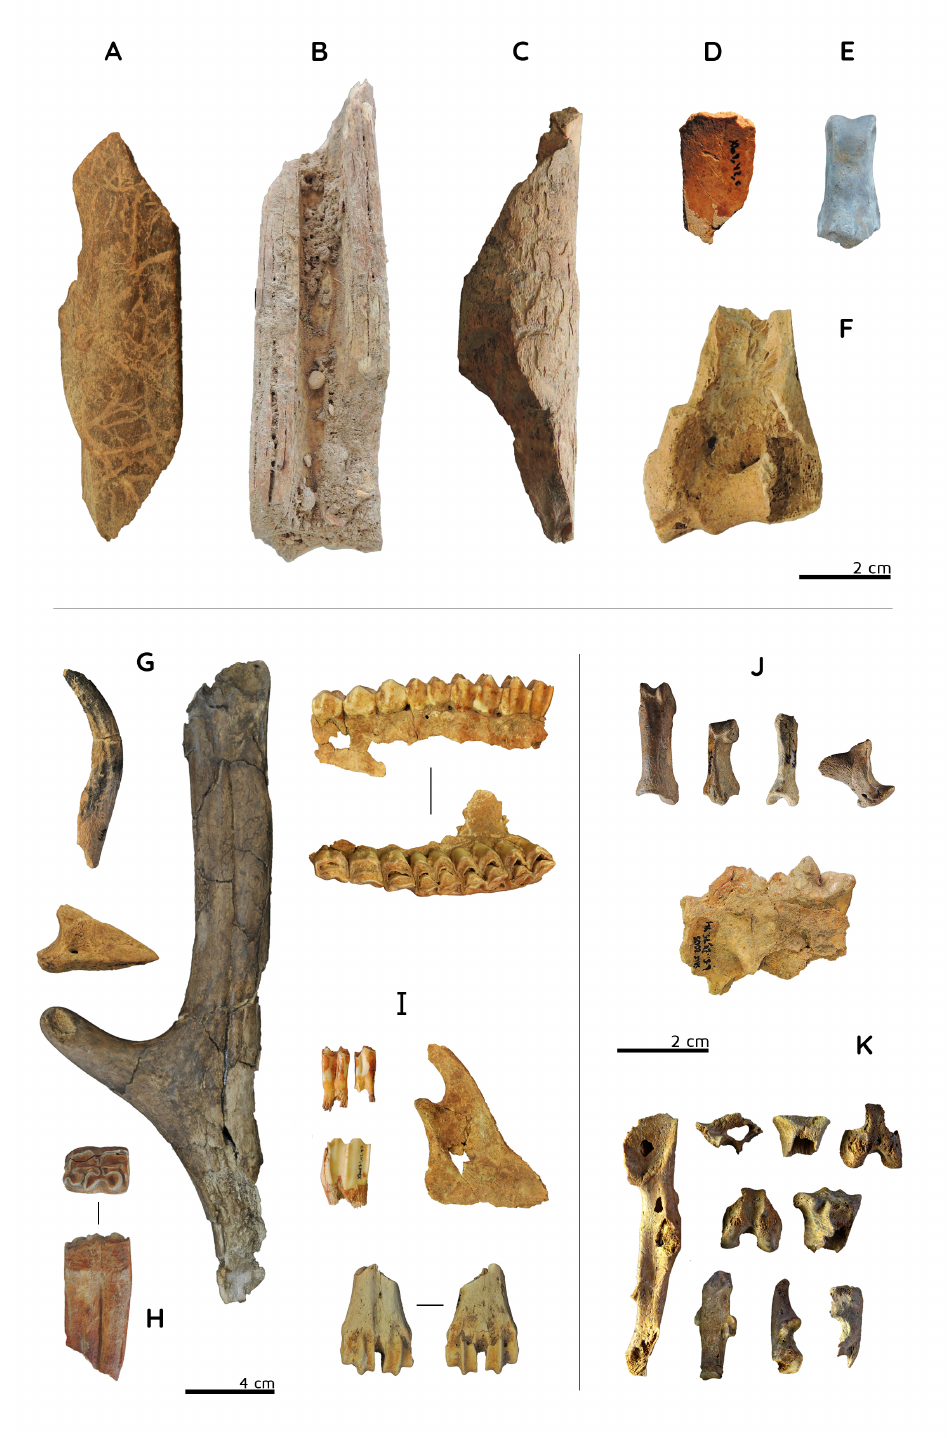
Figure 2. Taphonomic damage and bone remains recovered examples: manganese ( A ), concreteness ( B ), root-marks ( C ), bone flake ( D ), burned bone ( E ), erosion ( F ), bones, teeth and deer antler ( G ), bones and wild goat teeth ( H ), horse tooth ( I ), phalanges and lynx maxillary ( J ), and rabbit bones ( K